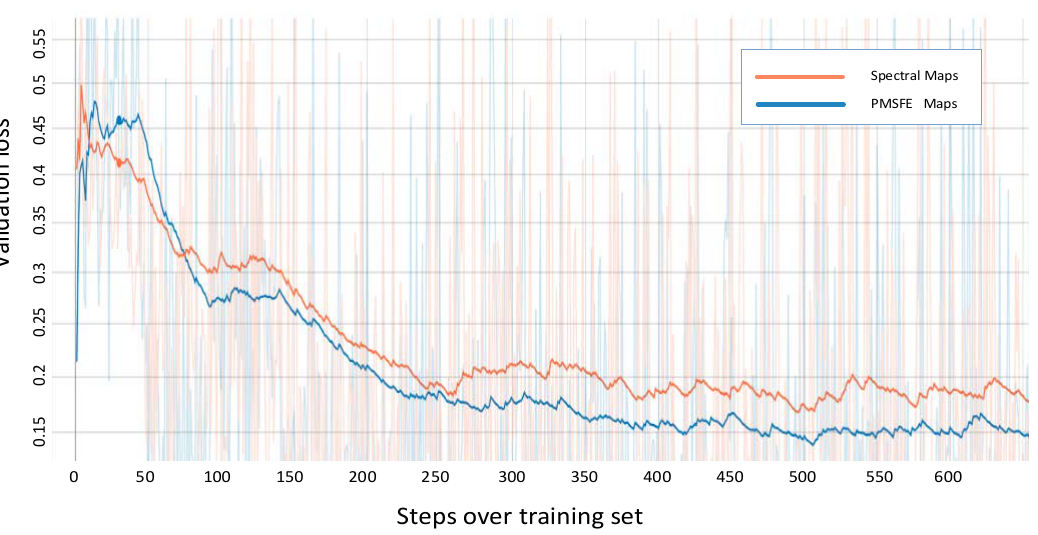
Figure 8. Validation loss of spectral maps and PMSFE maps over training set in ResNet-152. (Smooth = 0.987 in Tensorboardx).